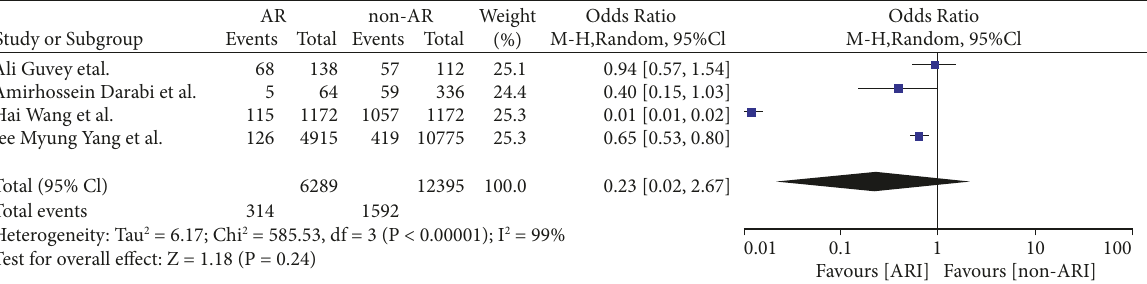
Figure 6: Incident hospitalization with COVID-19 with and without AR of stay forest